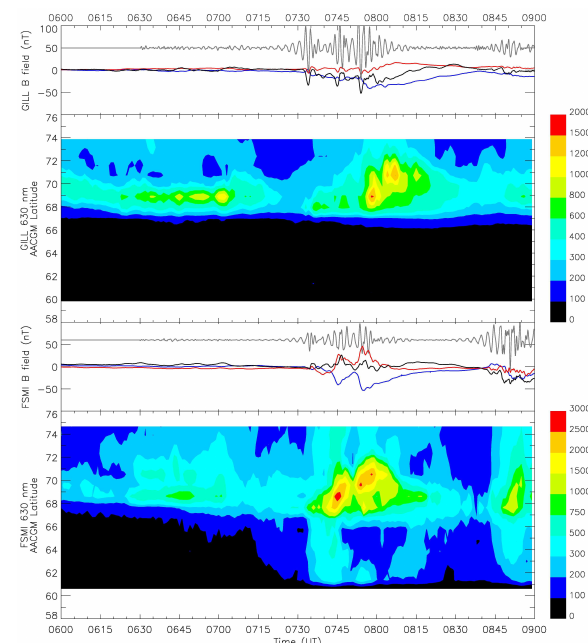
Figure 2 Magnetic field data (Panel 1 and 3) and MSP 630 nm emissions (panel 2 and 4) from 0600 to 0900 UT observed at Gillam and Fort Smith. In panel 1 and 3, the black, red and blue lines denote the X (magnetic north), Y (magnetic east), and Z (vertically downward) components of the magnetic field. Pi2 oscillations at both stations are also plotted in gray line on top of magnetometer traces with scale of 5 nT per minor tick.